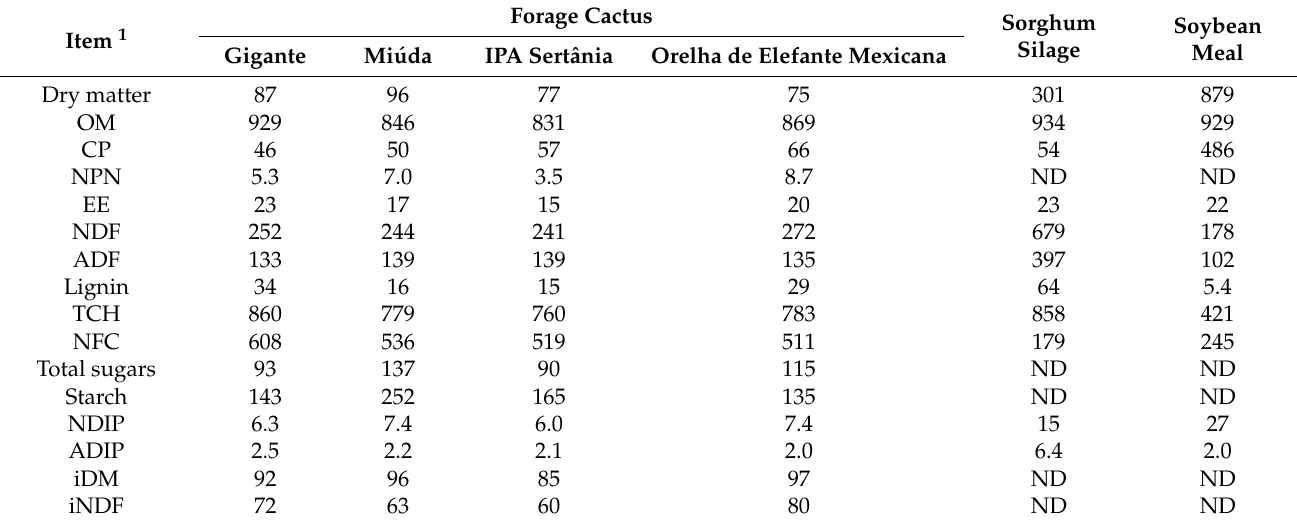
Table 1. Chemical composition of the experimental dietary ingredients (g/kg of DM, unless otherwise stated).